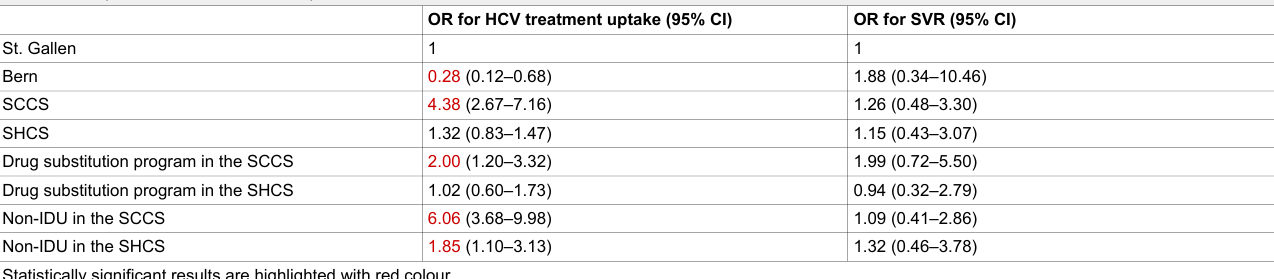
Table 4: Comparison of HCV treatment uptake and success between St. Gallen, Bern, SCCS and SHCS. OR for HCV treatment uptake (95%